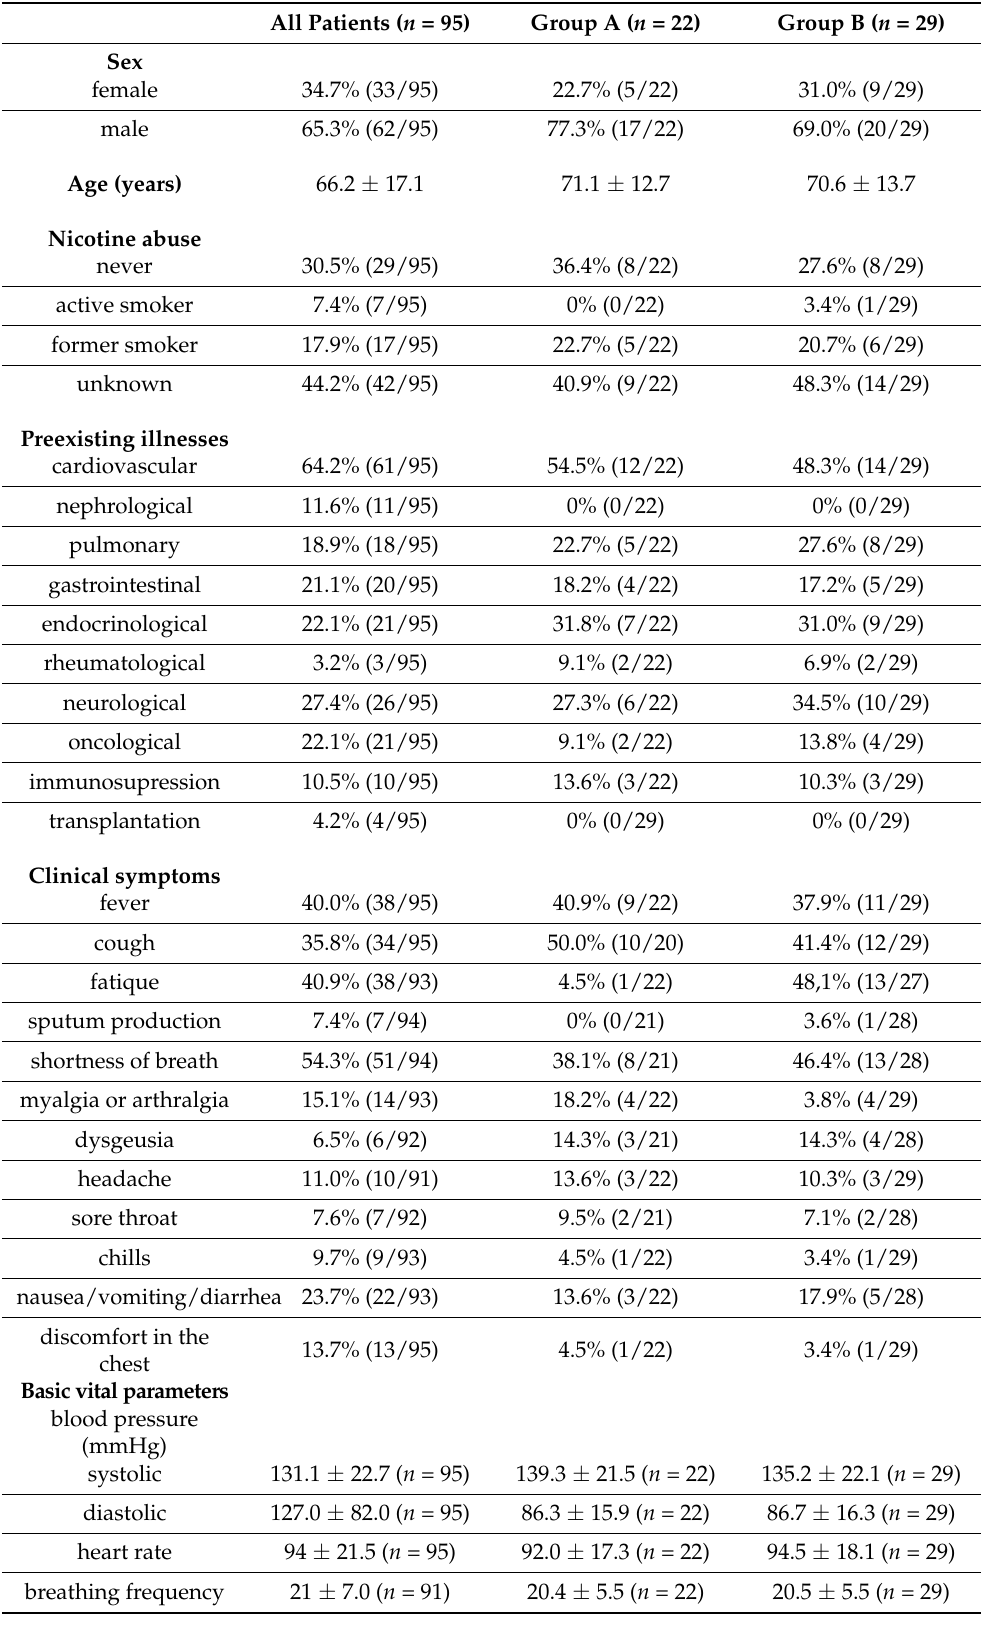
Table 2. Clinical characteristics of patients treated at the ED, including subgroup analysis of proven and probable COVID-19